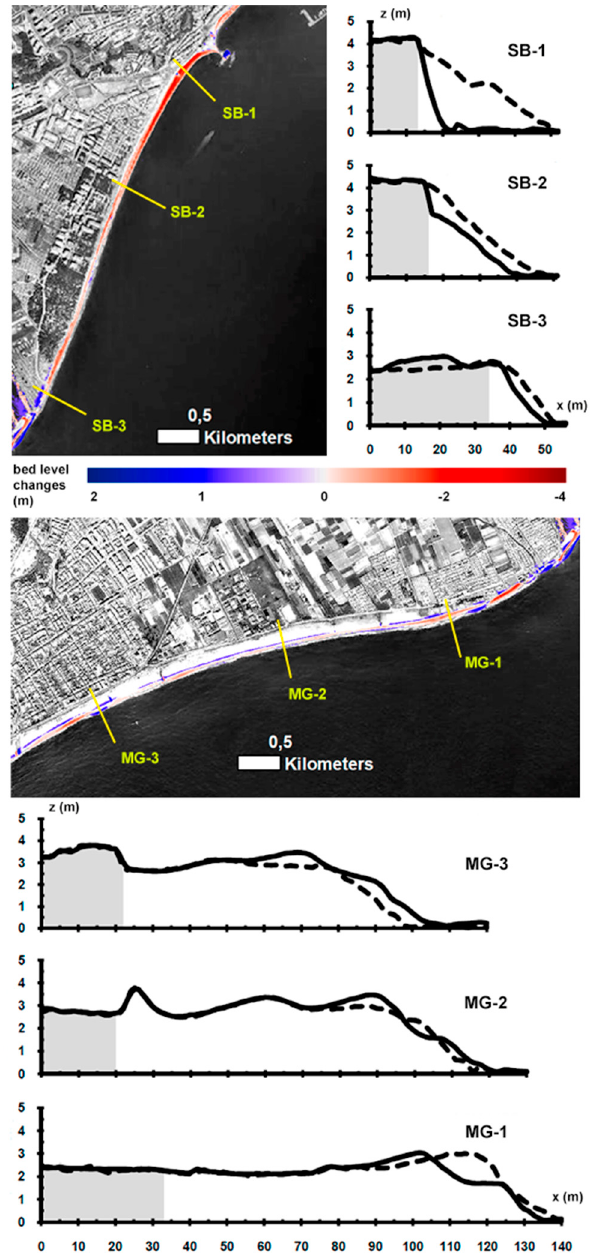
Figure 3. Morphologic changes after the St Esteve 2008 storm. Dashed line pre-storm and continuous line post-storm profiles. Grey shaded area represents de position of the promenade (north) or road (south).